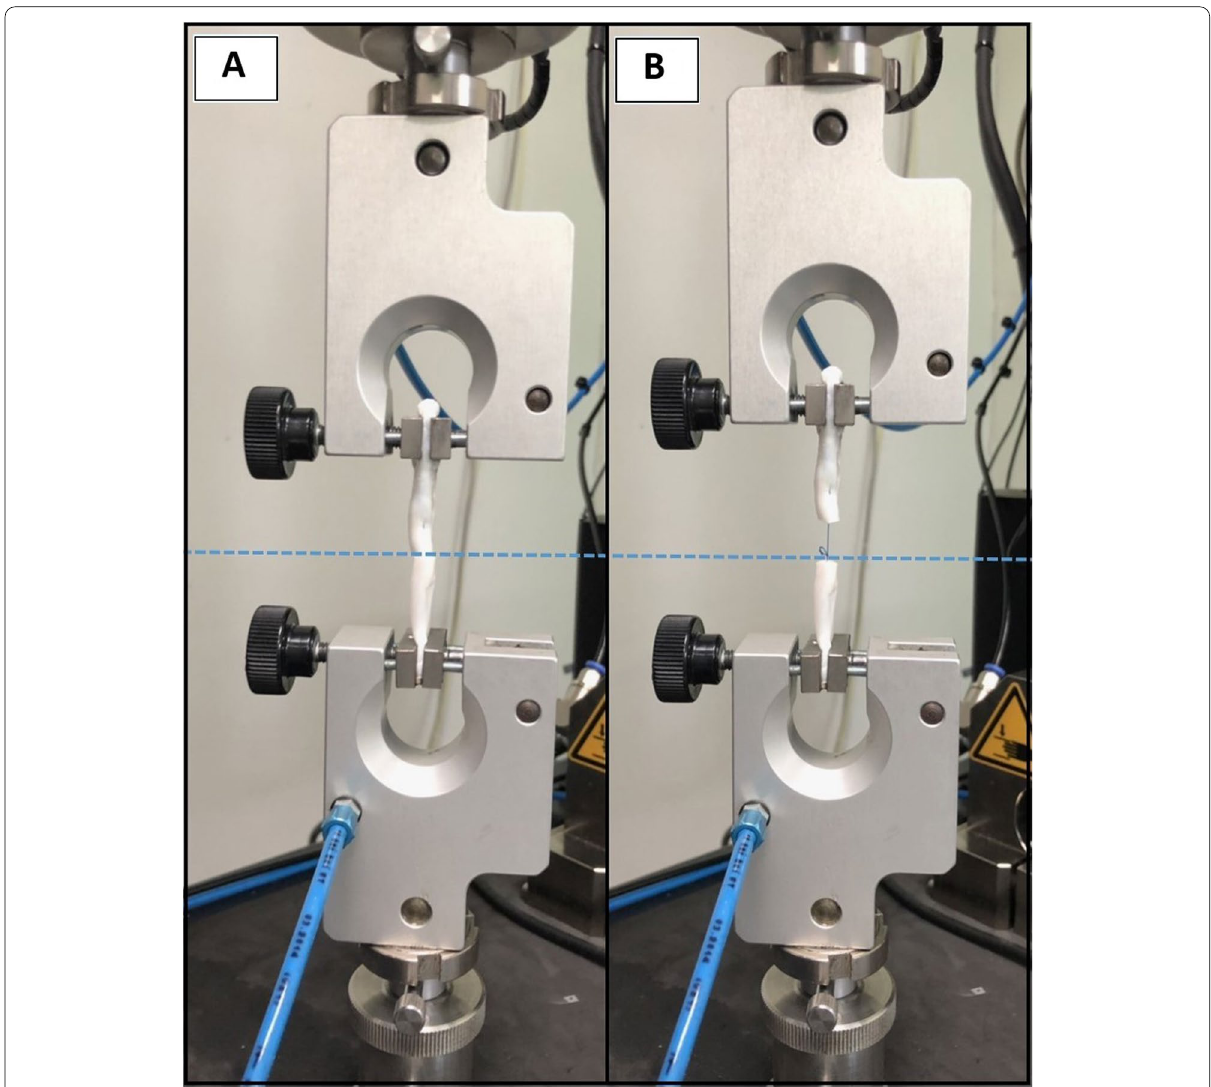
Fig. 4 Universal Testing Machine (ZwickRoell Z010), 2 grippers were maintained (3A), and the tensile strength was recorded until the suture thread was broken